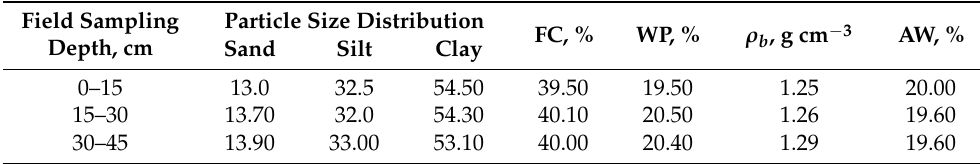
Table 1. The physical characteristics of the studied soil experiments. Field Sampling